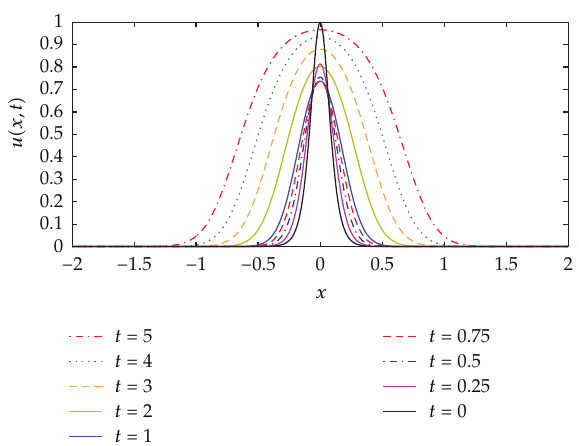
Figure 6: Numerical solutions for (cid:3) 5.5 (cid:5) and (cid:3) 5.10 (cid:5) with λ (cid:8) 1.